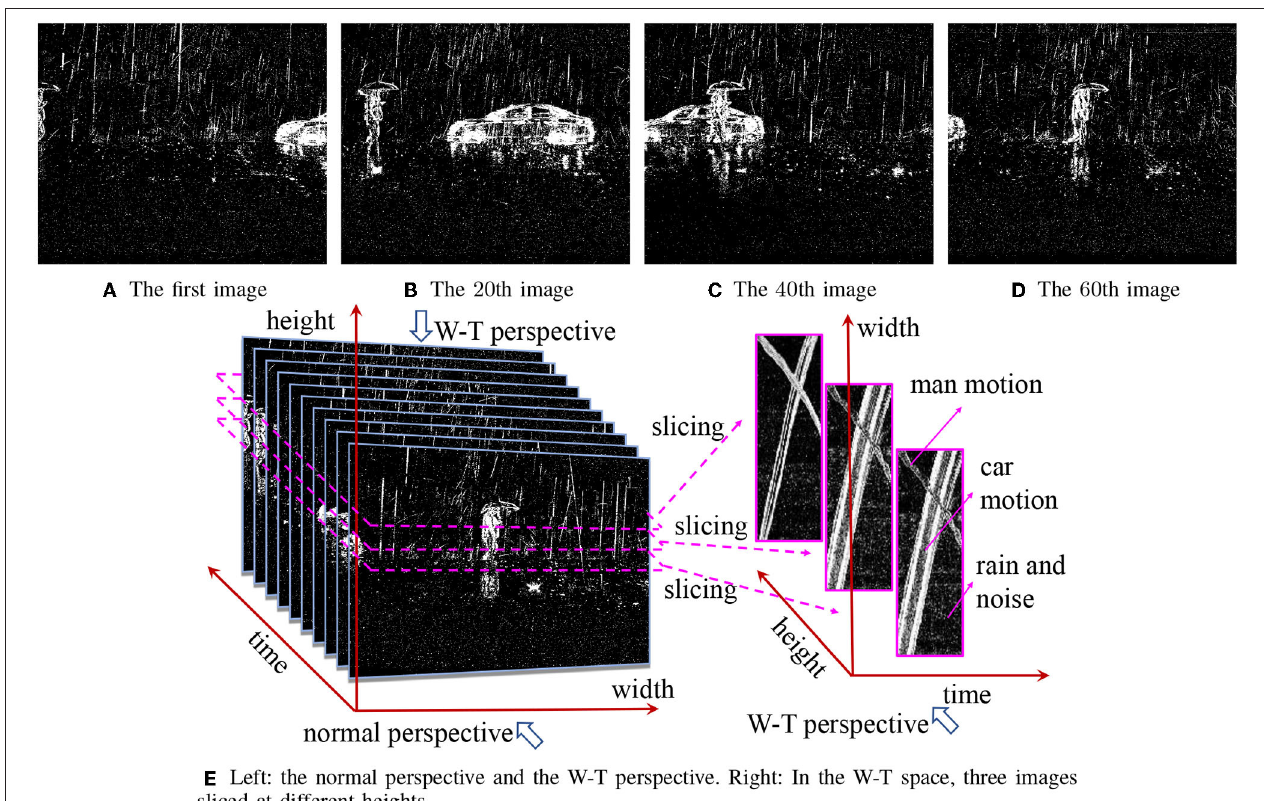
FIGURE 4 | (A–D) Four frames from a rainy DVS sequence comprising 60 images. (E) Their W-T